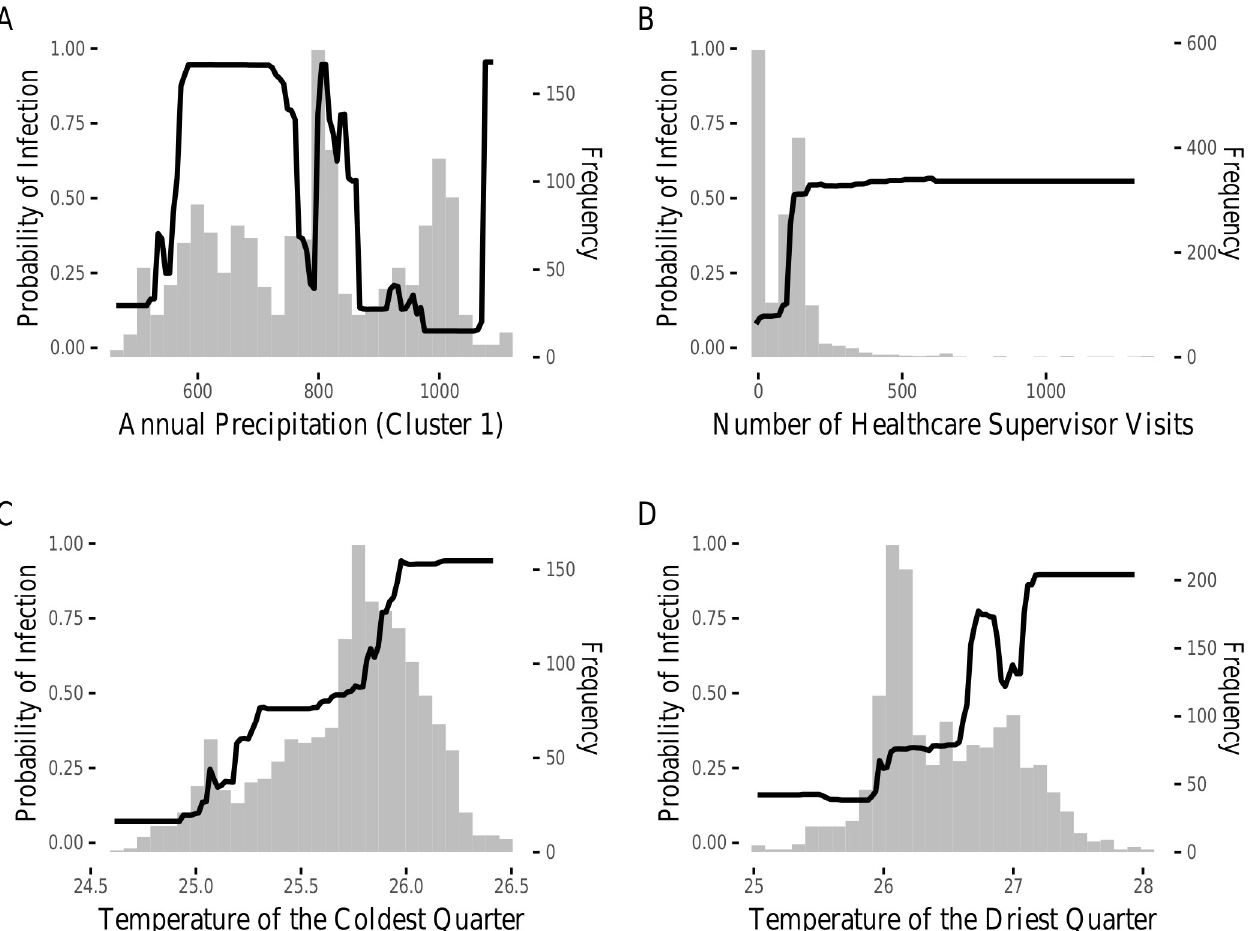
Fig 4. Hotspot-level partial dependence plot. Partial dependence plots showing the effect of (a) cluster 1 (represented by annual precipitation [Bioclim 12]), (b) number of healthcare supervisor visits, (c) temperature of the coldest quarter [Bioclim 11], and (d) temperature of the driest quarter [Bioclim 9] on probability of dog infection. Histograms represent the distribution of values for these covariates amongst all training villages.